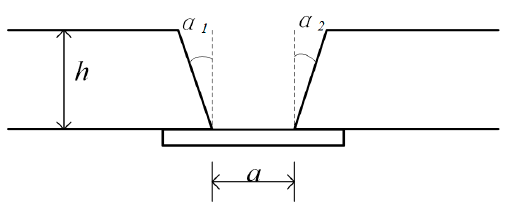
Figure 12. Groove Geometry Information.